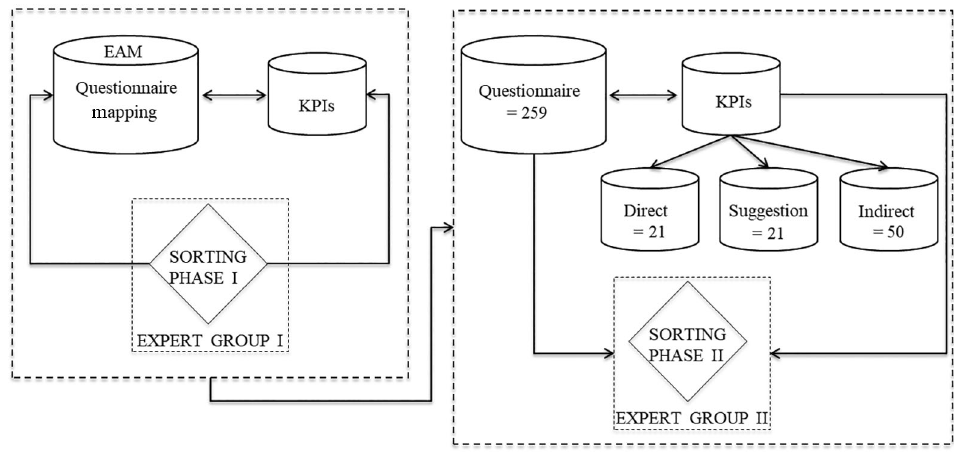
Fig. 1. The concept of the